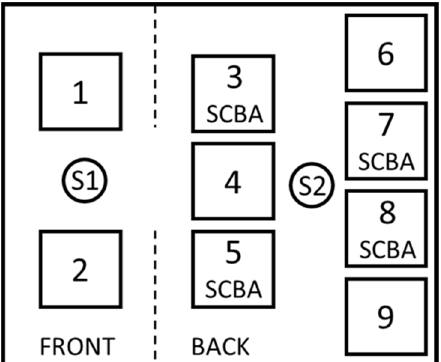
Figure 1. Seating of a standard tactical crew in LF 20 cabin with self-contained breathing apparatus (SCBA) on four seats and ProxiCube positions S1, S2.